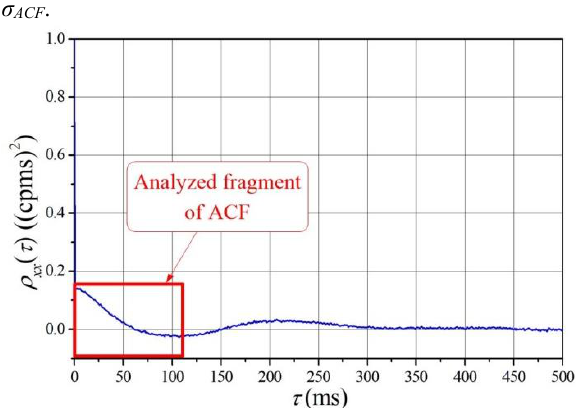
Fig. 2. Exemplary plot of ACF obtained in the selected experiment. Red frame indicated the fragment which is related to the change of air